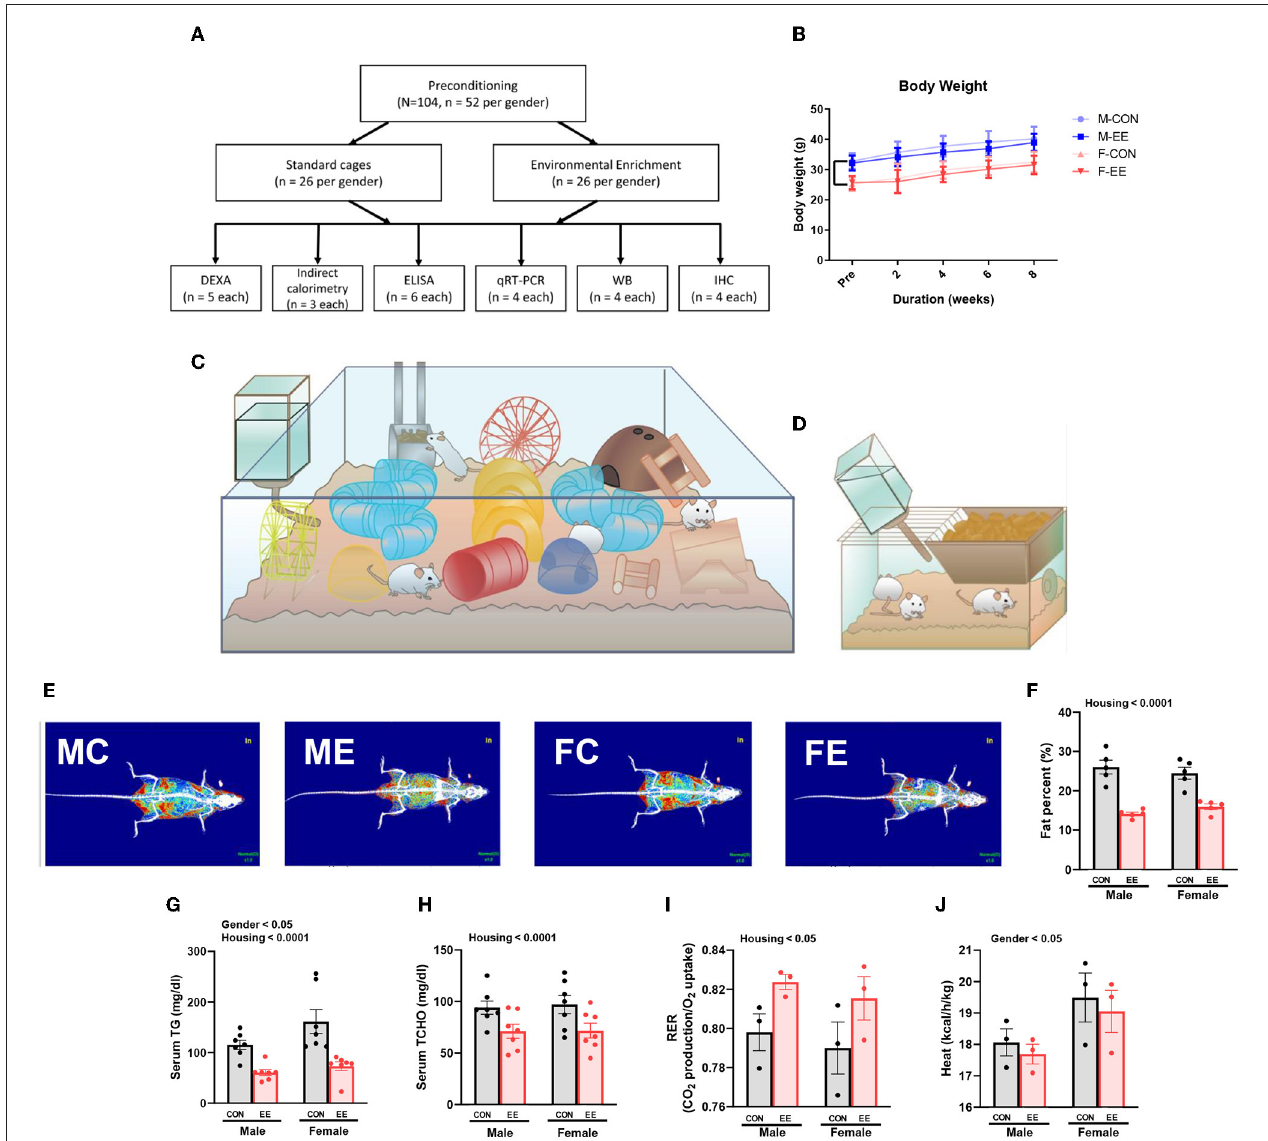
FIGURE 1 | Differential metabolic change by sex sensitivity and exposure to EE in normal models. (A) The experimental scheme for normal models. (B) Body weight change at 2-week interval ( n = 26 per group). The representative figures of (C) EE cage and (D) control cage. (E) The representative DXA image of each group. (F) Percentage fat in male and female mice exposed to control (CON) or enriched (EE) cages ( n = 5 per group). After exposure to EE or control cage, blood biochemical analysis ( n = 7 per group) and indirect calorimetry ( n = 3 per group) were conducted. (G) Serum triglyceride. (H) Serum total cholesterol. (I) Respiratory exchange ratio. (J) Heat. Two-way ANOVA with Tukey multiple comparison test. Significant sex effect, significant housing effect, and the significant interaction between sex and housing were noted with p -value. Data are means ±